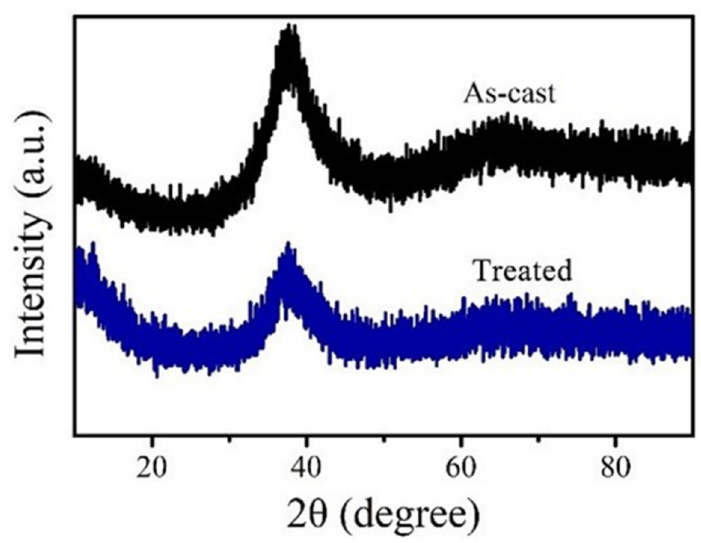
Figure 1. XRD patterns of Zr 54.46 Al 9.9 Ni 4.95 Cu 29.7 Pd 0.99 BMGs before and after HRRF treatment [17].